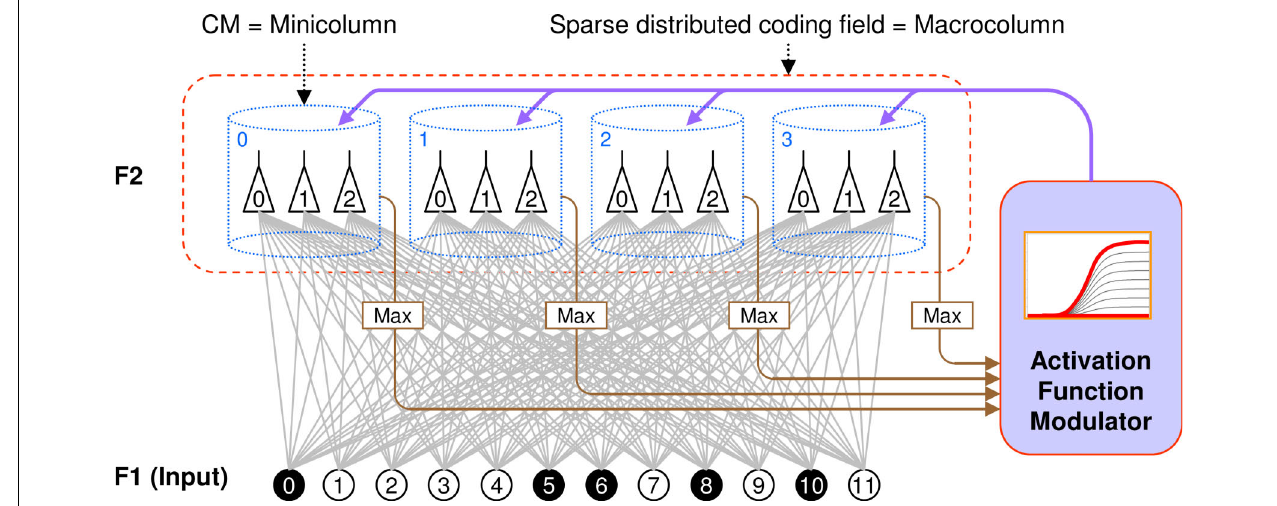
all-to-all: gray lines signify initially 0 weights. The familiarity ( G ) of the input is proposed to be computed via a subcortical, neuromodulator- based mechanism, which then modulates the F2 unit activation function parameters (e.g., sigmoid height) contingent on G (purple arrows). See